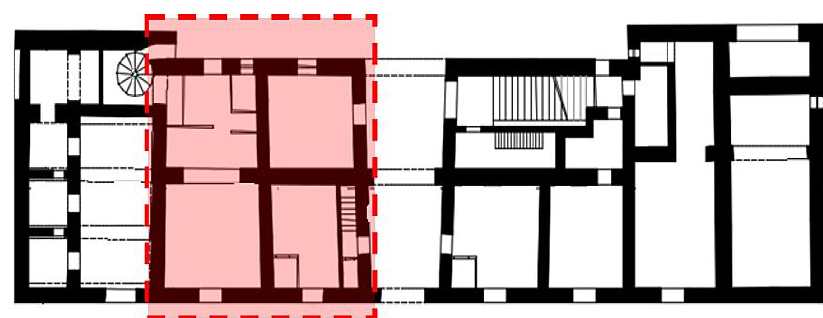
Figure 6. Intermediate structural unit in isolated condition.